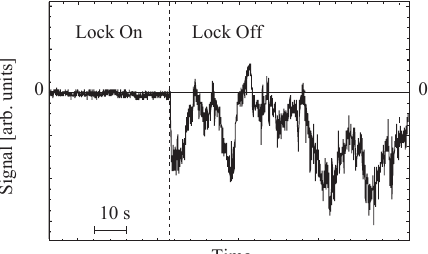
Figure 10. Lock-in output (error signal) obtained by scanning the laser across a resonance line for various phase shifts between the absorption signal and the modulation: ( a ) φ = 0 ◦ , ( b ) φ = 90 ◦ and ( c ) φ = 180 ◦ .